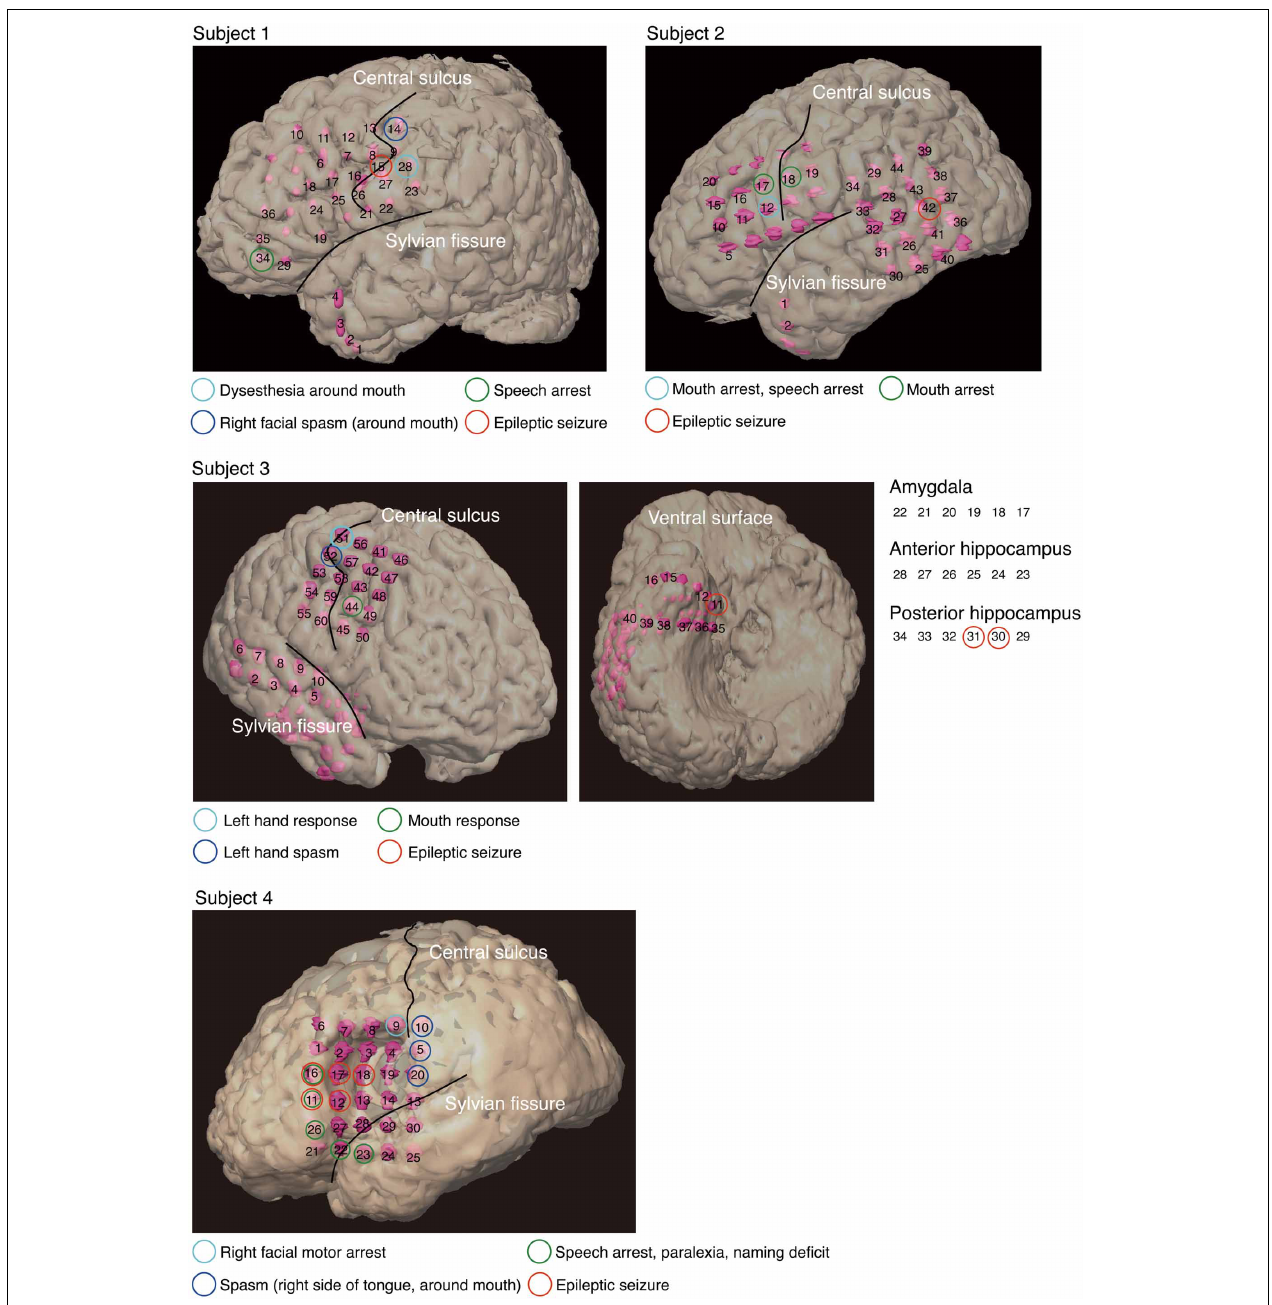
FIGURE 1 | Electrode locations and responses to electrical stimulation for each subject, superimposed onto positions of the implanted subdural electrodes. The two black lines delineate the locations of the central sulcus and Sylvian fissure. Pink objects represent the electrodes. Unnumbered electrodes are those that were not used in this analysis due to severe measurement noise. Each colored circle indicates a response to